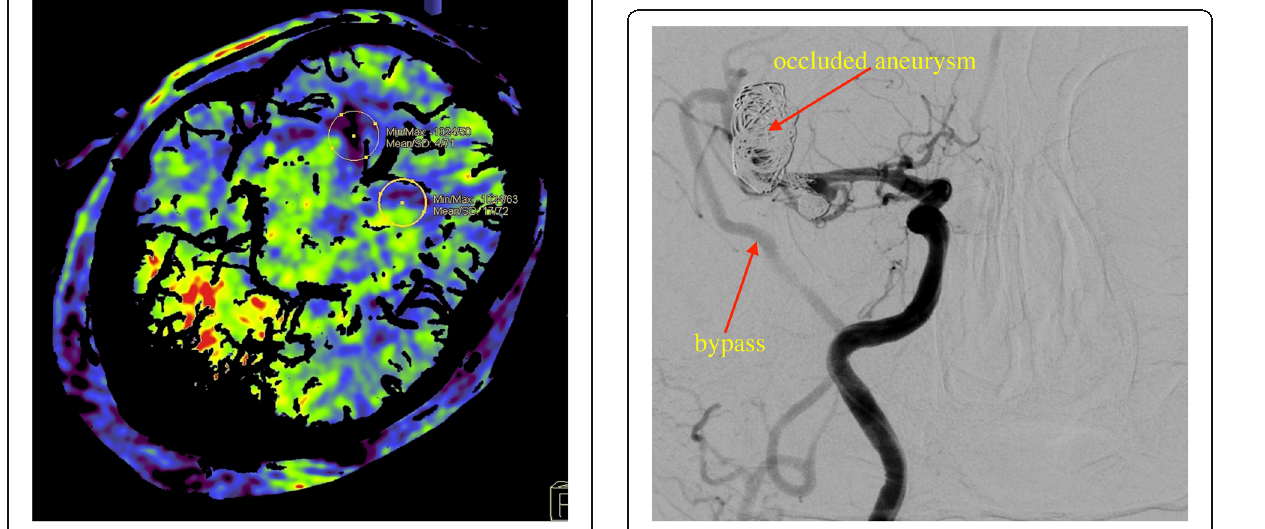
Fig. 5 Flat panel CT perfusion (CBV) showed no perfusion differences between brain hemispheres